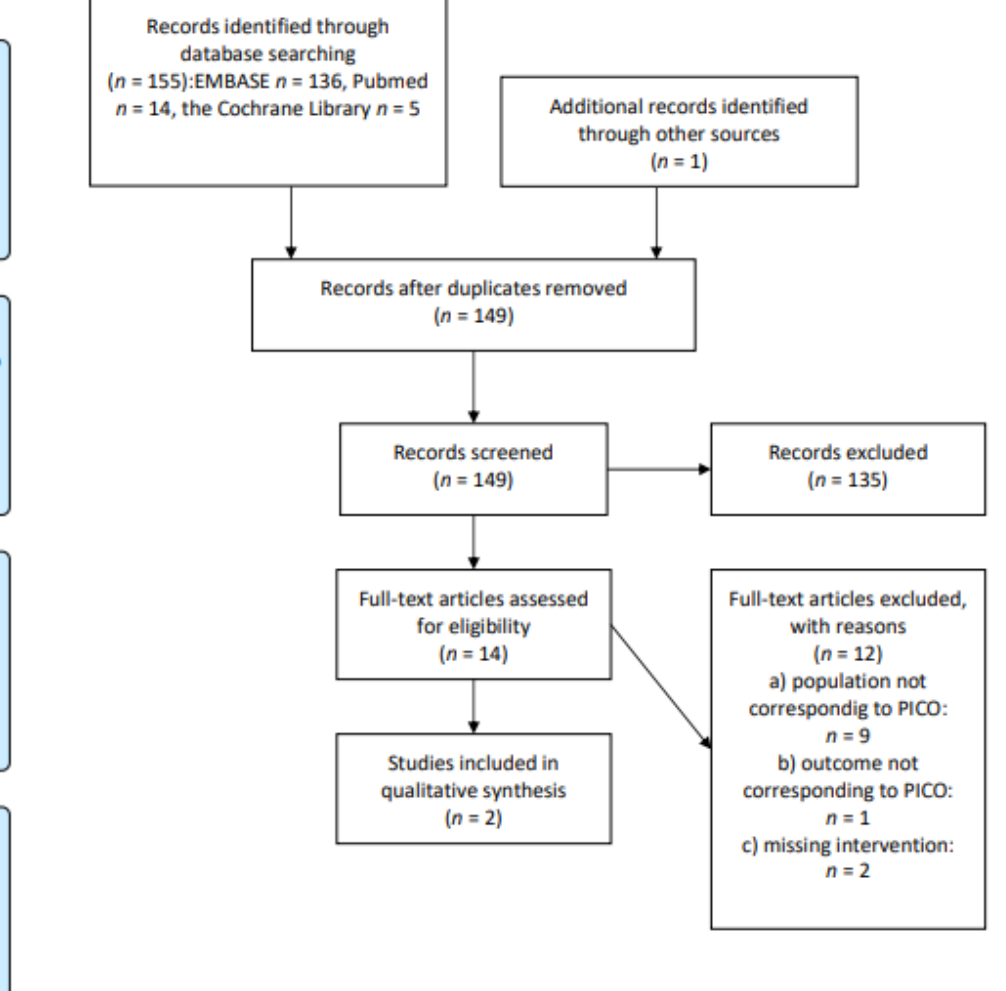
Figure 3. PRISMA flow-chart on bodyweight and BMI.